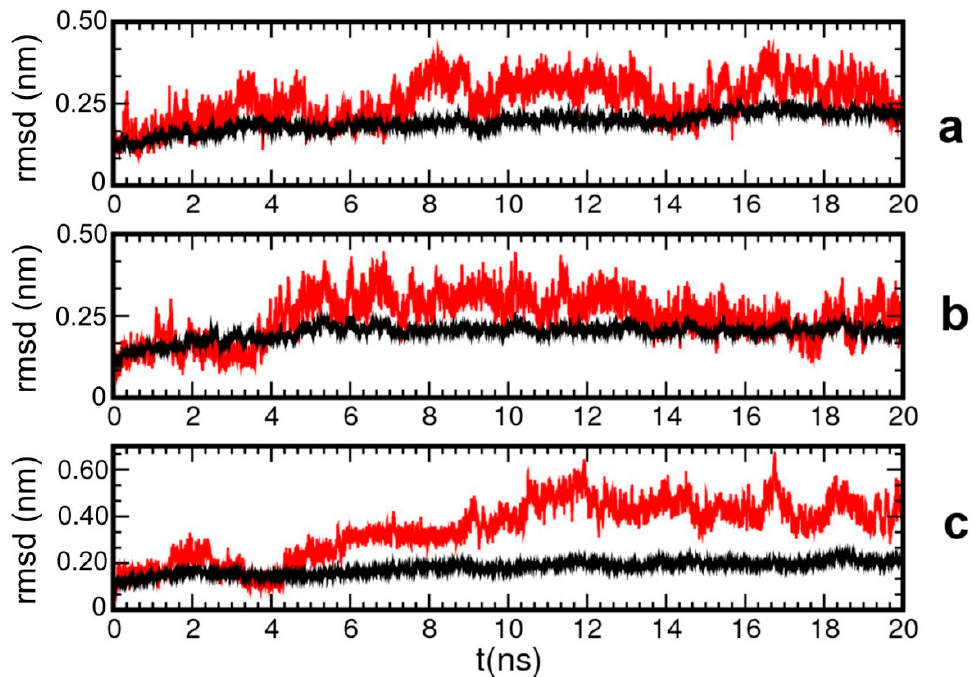
Figure 4. Time variation of root mean square distances (rmsd) with respect to the initial configuration calculated for all the pepsin residues (black line) and for the residues of the flap region (red line). Panel ( a ) simulation with the neutral channel (Model 1). Panel ( b ) simulation with the charged silica channel (Model 2). Panel ( c ) simulation with the charged channel and a lower number of water molecules (Model 3).